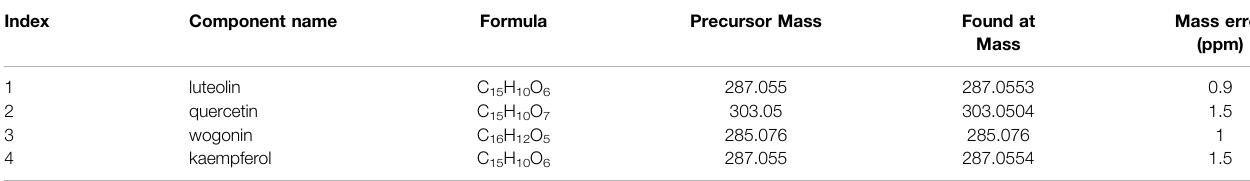
TABLE 2 | Identi fi cation of the compounds of LWWL in